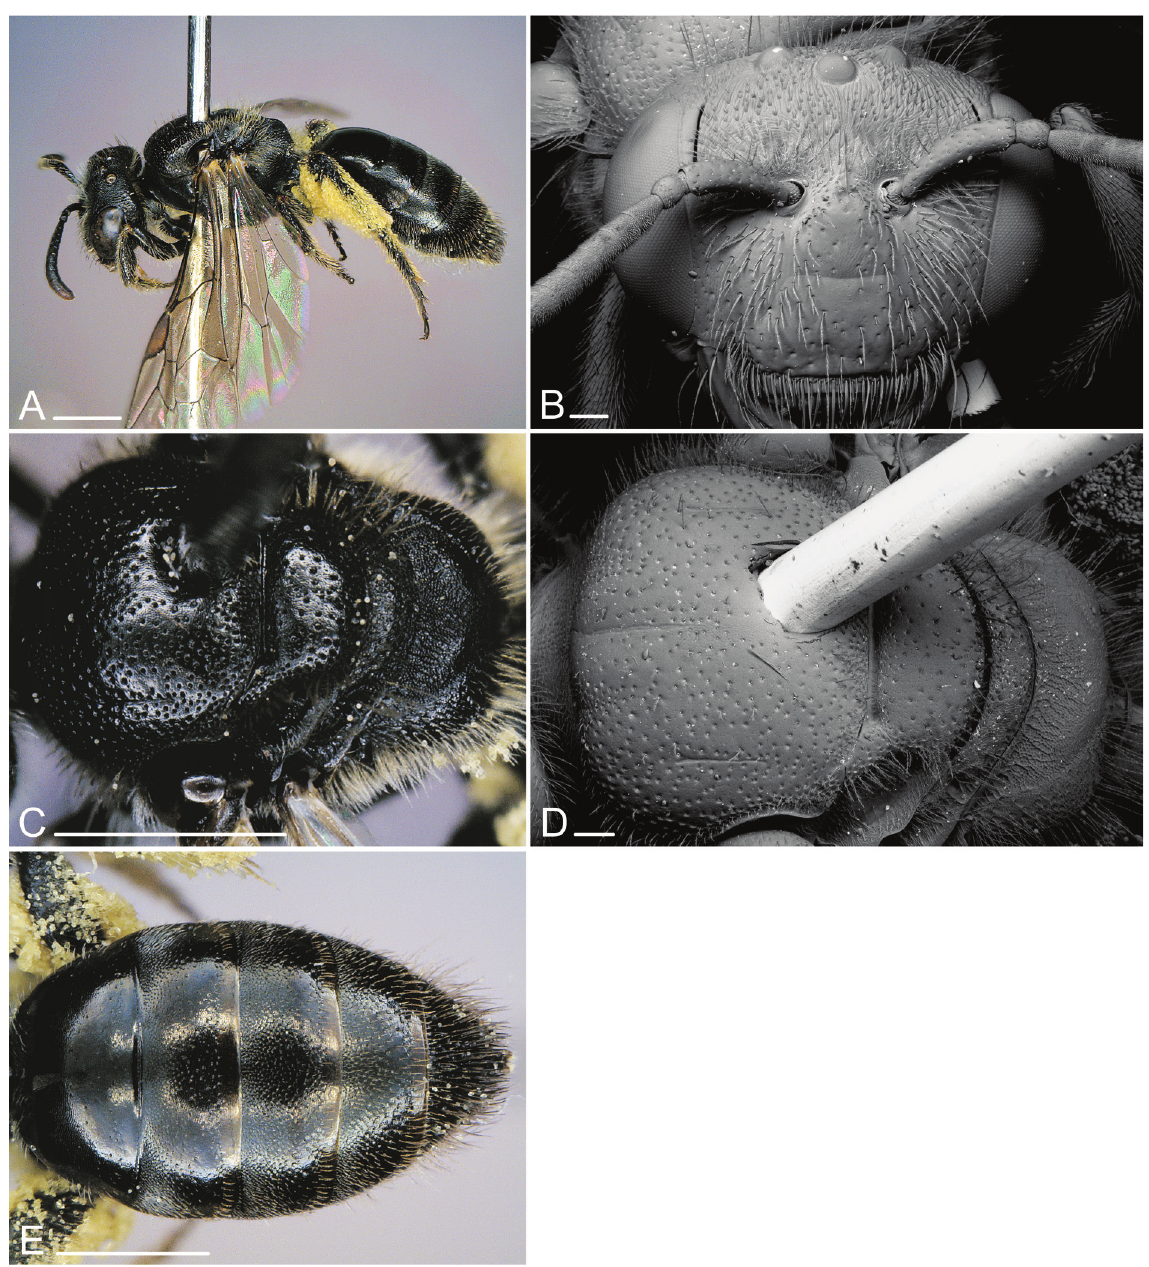
Fig. 32. Scrapter ulrikae sp. nov., ♀. A . Lateral view. B . Head (SEM). C . Thorax (dorsal view). D . Thorax (dorsal view, SEM). E . Metasoma (dorsal view). Scale bars: photos: 1 mm, SEM: 0.1